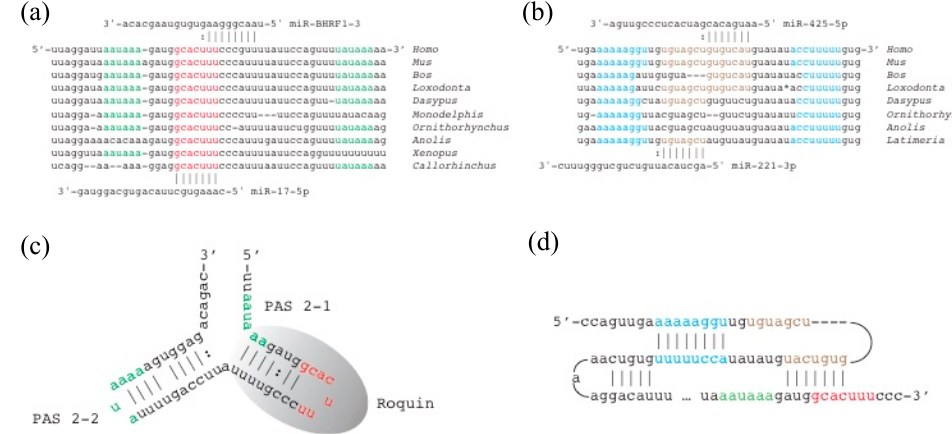
Figure 3. Sequence alignments and predicted structures of the PTEN 3 ′ UTR. ( a ) The sequence surrounding the “roquin hairpin” with predicted target sites of miR-17-5p and miR-BHRF1–3 also shown. ( b ) Comparative sequences of the “upstream hairpin” with predicted target sites of miR-221-3p and miR-425-5p also shown. ( c ) Structure reported in [83] with the roquin hairpin at lower right with location of polyadenylation signals. ( d ) Proposed pseudoknot in which GUGUCAU from the upstream hairpin binds to AUGGCAC, preventing formation of the roquin hairpin. In all figures, the complementary arms of the upstream hairpin in blue lettering. Polyadenylation signals in green lettering. Target sites for miR-221-3p and miR-425-5p in brown lettering. Target site for miR-17-5p in red lettering. The two sequences of ( a , b ) are separated by 23 highly conserved nucleotides. Common names of species: human ( Homo ), mouse ( Mus ), ox ( Bos ), elephant ( Loxodonta ), armadillo ( Dasypus ), opossum ( Monodelphis ), platypus ( Ornithorhynchus ), lizard ( Anolis ), toad ( Xenopus ), coelacanth ( Latimeria ), elephant shark ( Callorhinchus ).